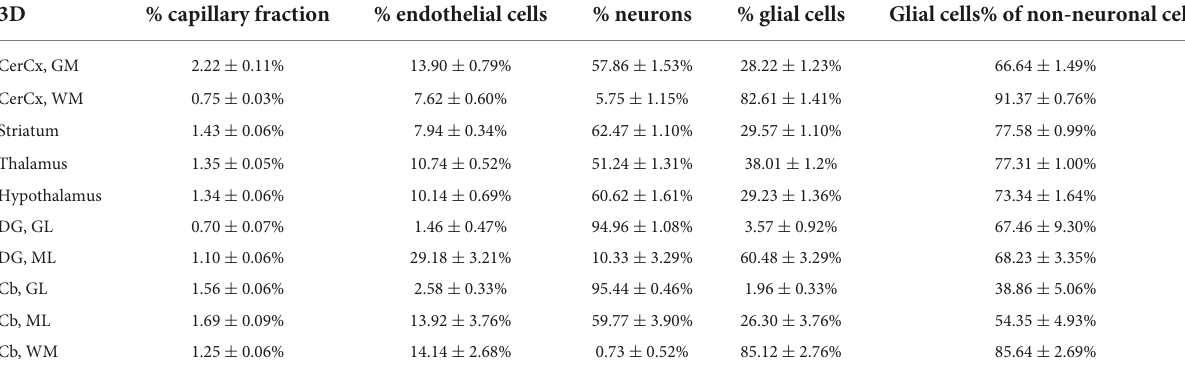
Valuescorrespondtotheaverageacrosssitesineachstructureoftwomice(#1and#2).CerCx,cerebralcortex;GM,graymatter;WM,whitematter;GL,granularcelllayer;ML,molecular celllayer;Cb,cerebellum. TABLE 4 Fractional cellular composition of different structures of the mouse brain, quantified in 2D.